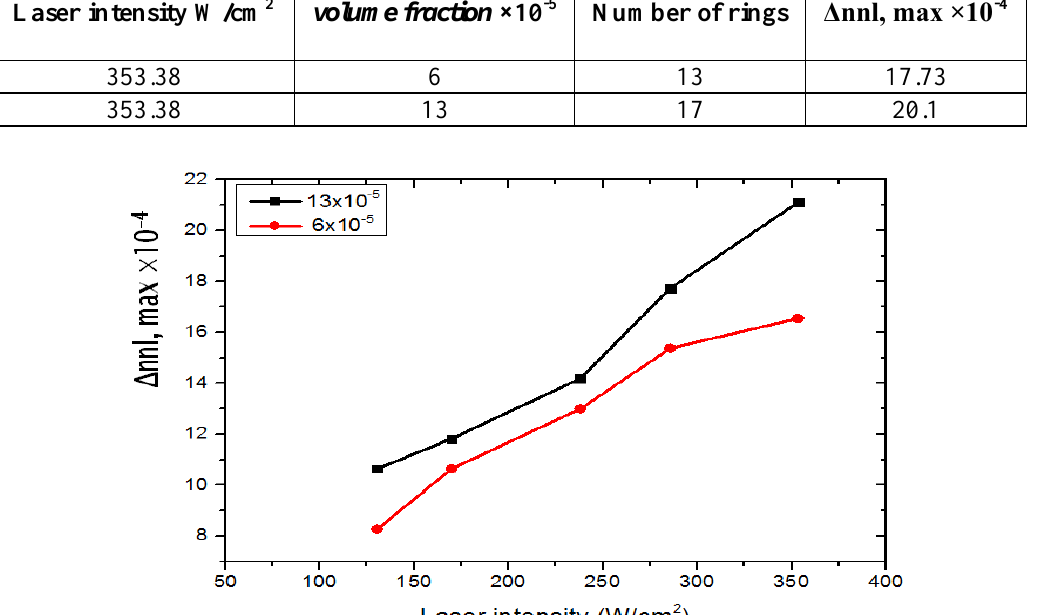
Table 2: The maximum change of nonlinear refractive index and their coinciding at two volume fraction in MWCNTs.